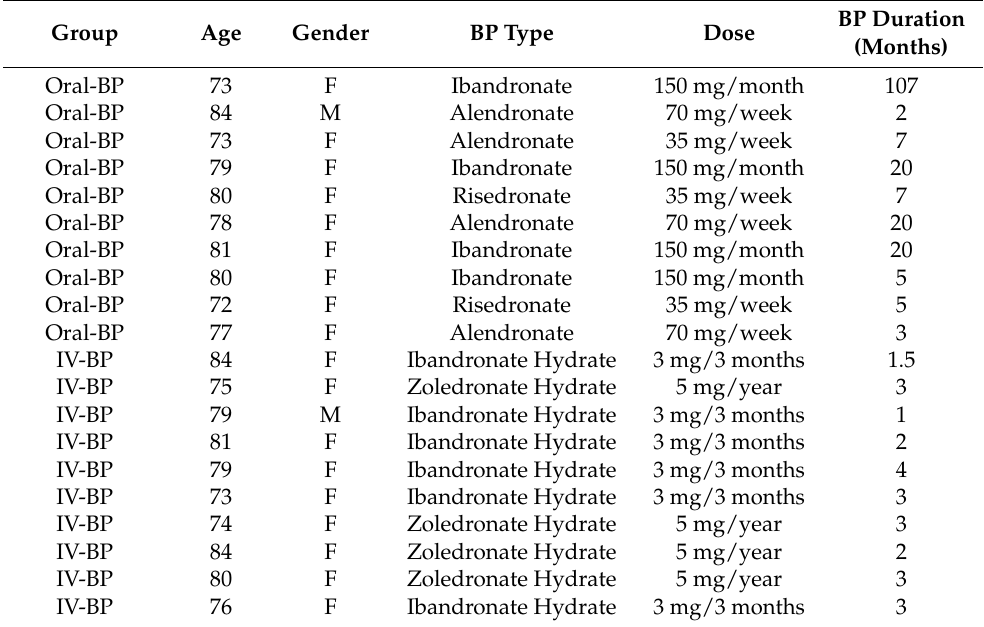
Table 1. Baseline characteristics of patients selected for the study ( N = 20).